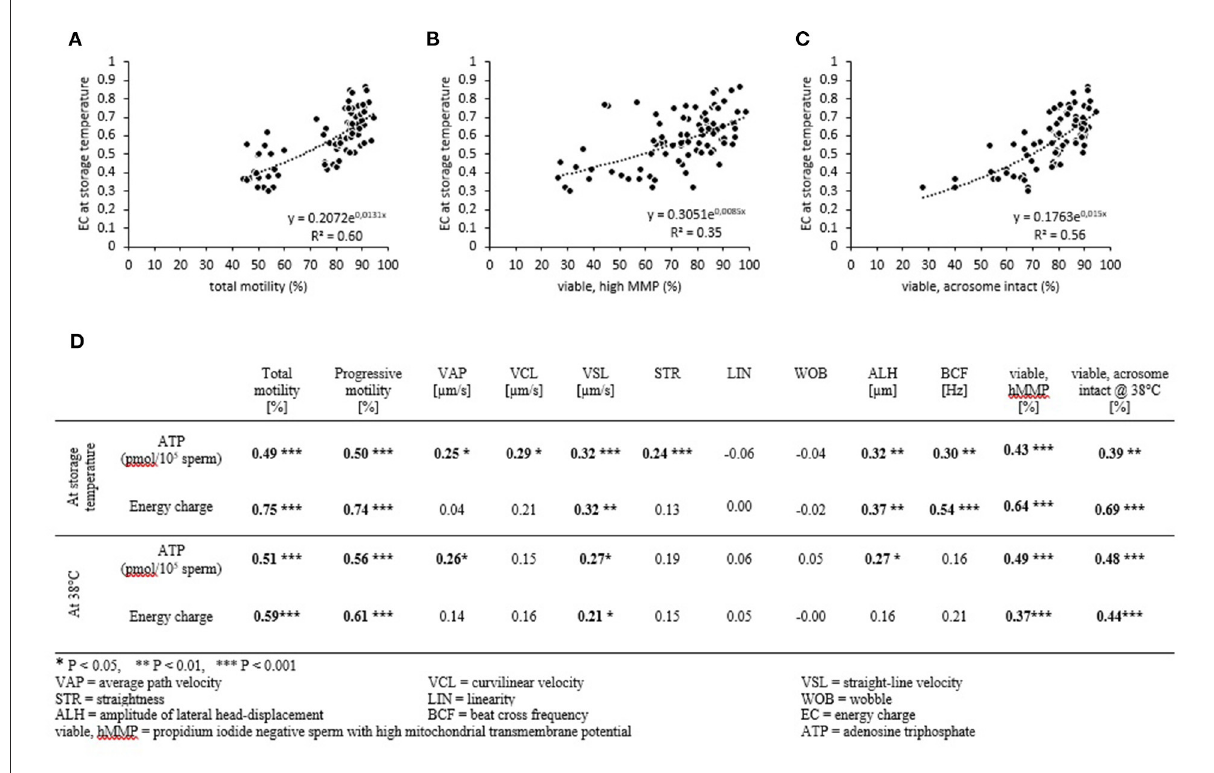
FIGURE5 Correlation between energy status, mitochondrial function, and sperm motility. Spearman correlation coefficients for energy charge (A–D) and ATP content (D) with selected sperm parameters. Samples were assessed after storage (A–C) and after incubation at 38 ◦ C for 30min (D) . Data from all storage temperatures and times were combined ( n = 84